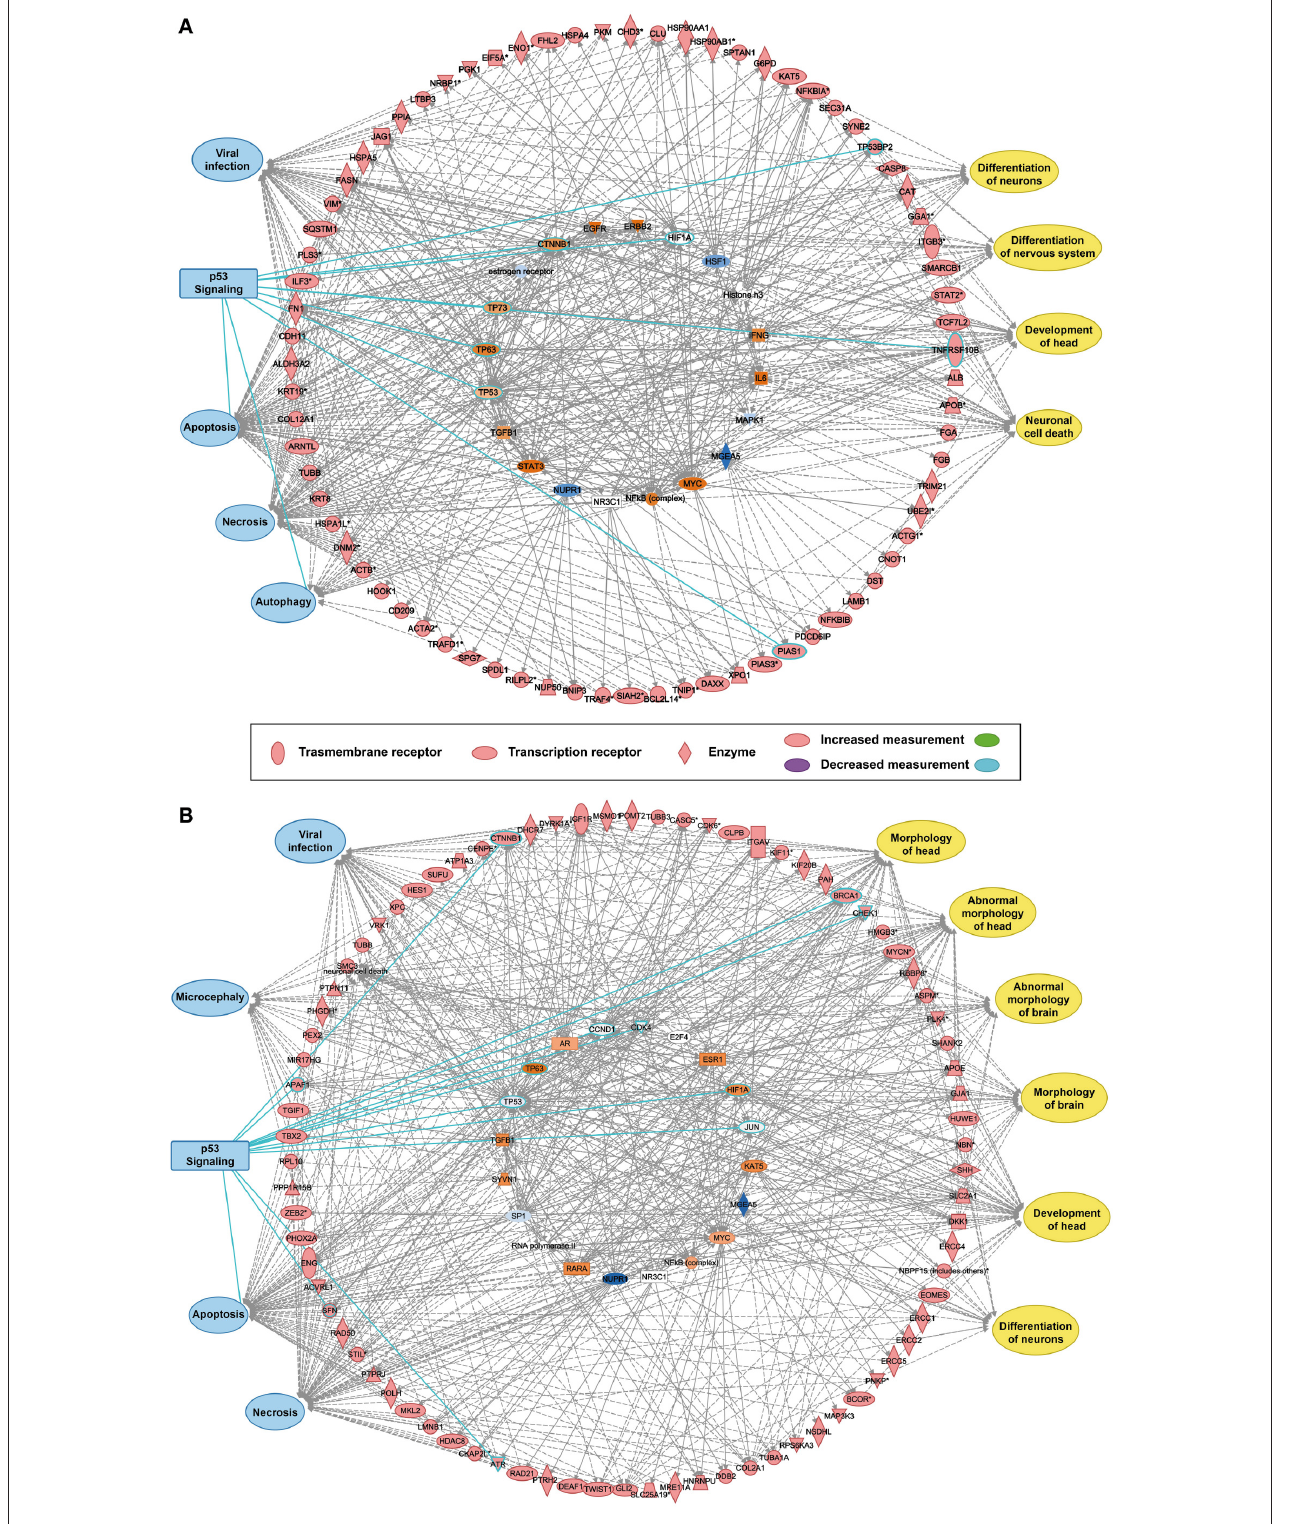
FIGURE 1 | Transcriptional regulatory network and P53 signaling pathways associated with ZIKV infection and microcephaly. (A,B) Transcriptional regulatory networks of ZIKV-related (A) and microcephaly-associated (B) human proteins.